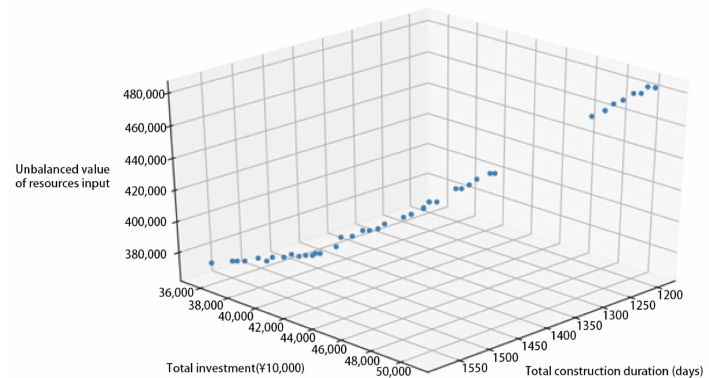
Figure 5. Spatial distribution of optimal Pareto solutions after 300